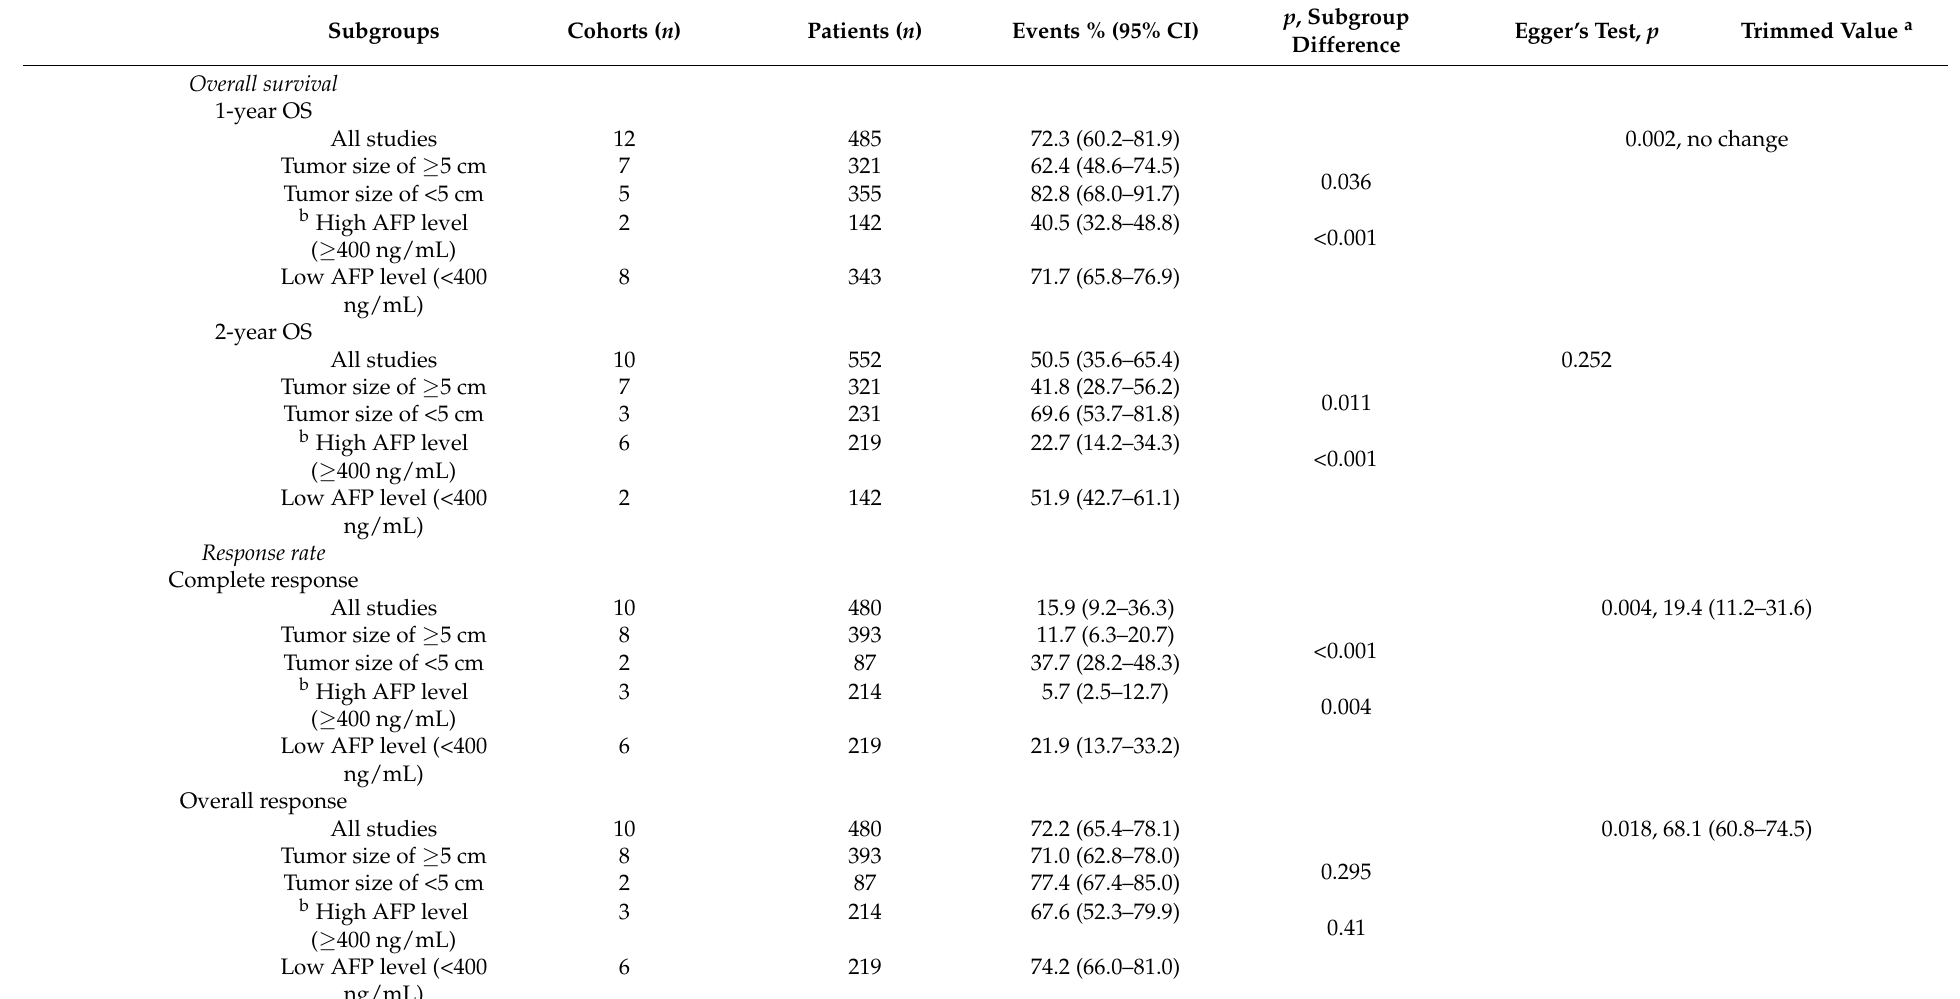
Table 3. Pooled analysis of oncologic